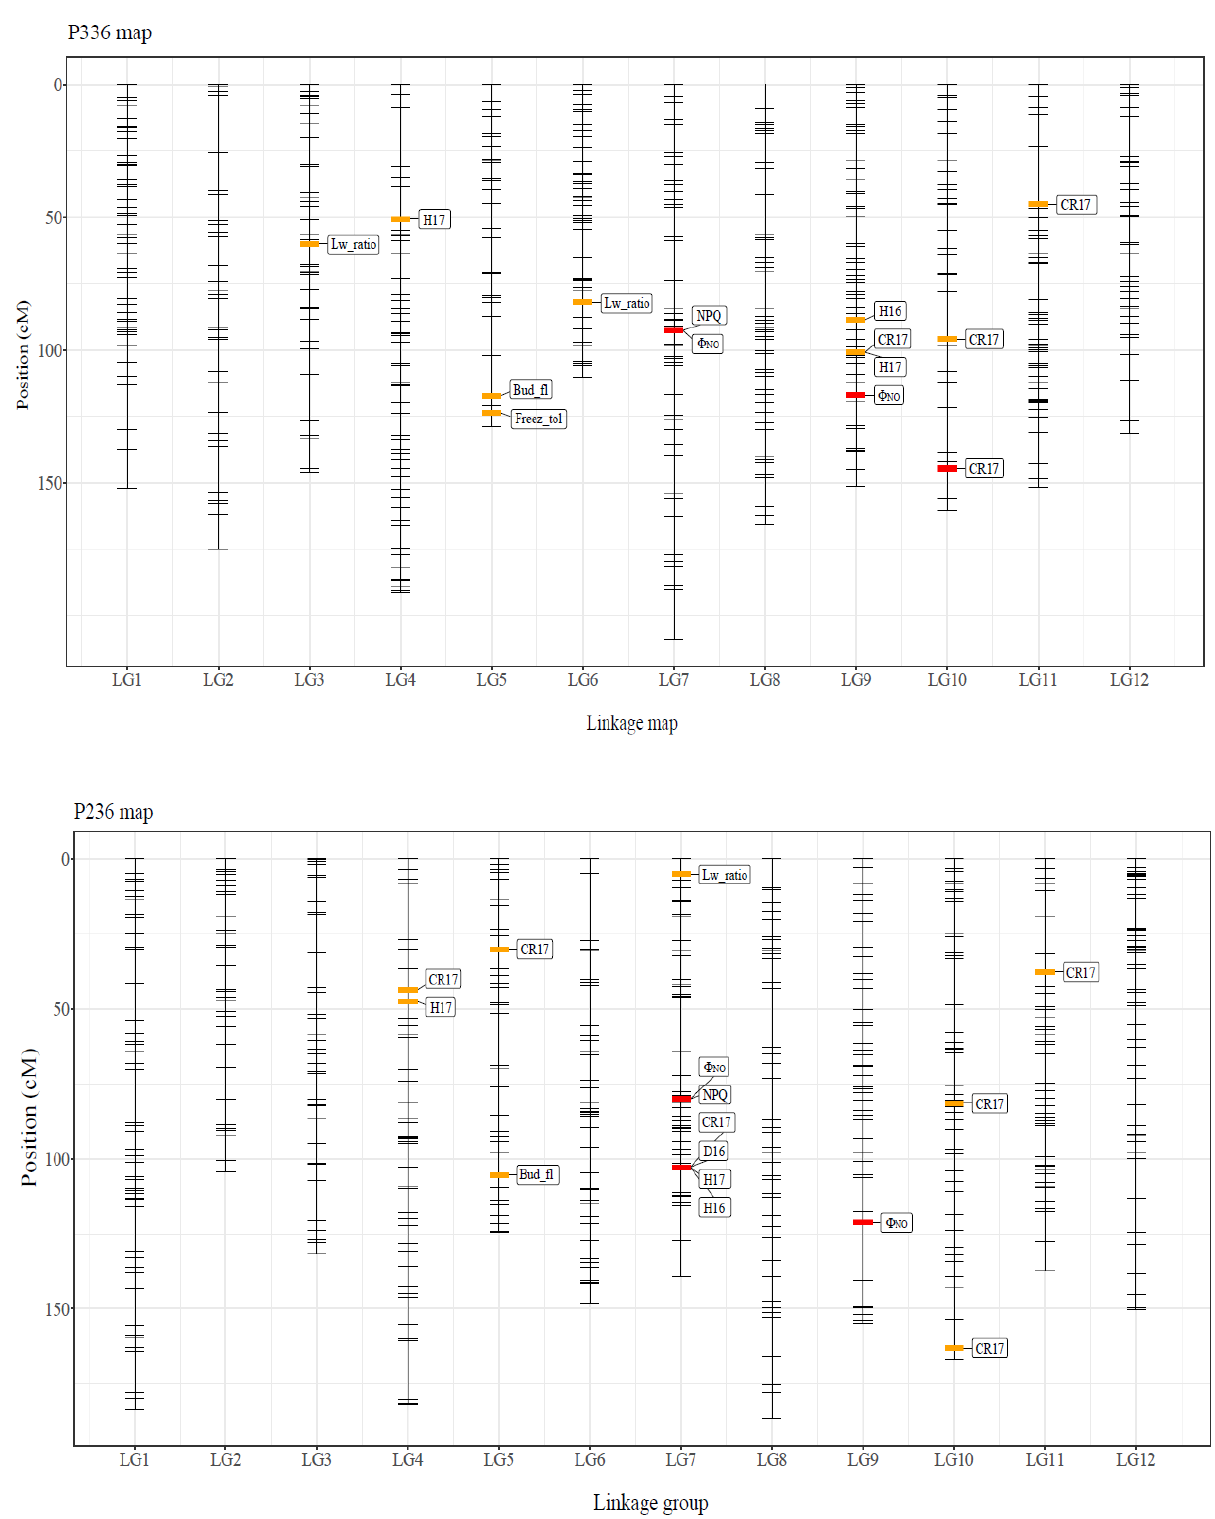
Figure 3. QTL mapping for the 15 functional traits. P336 and P236 maps were demonstrated in the upper and lower panels, respectively